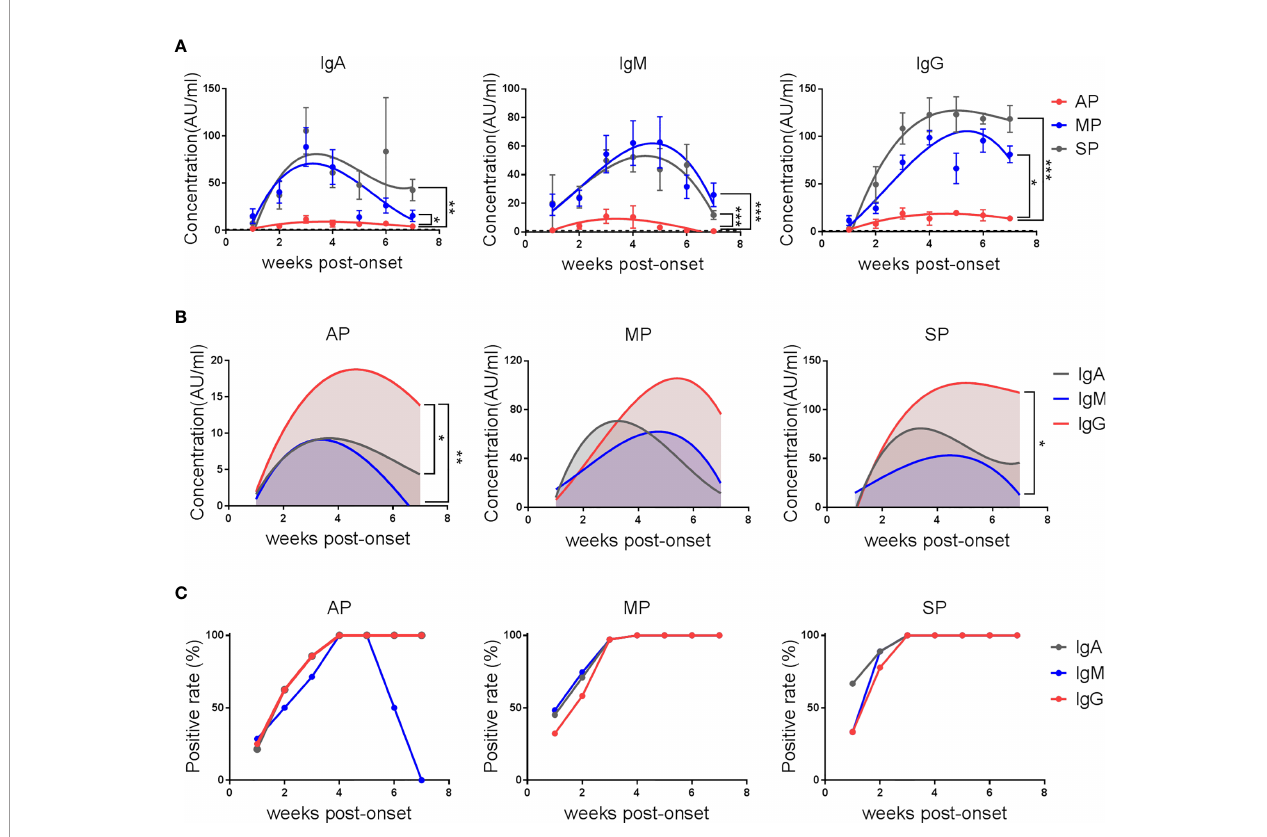
FIGURE 1 | The kinetics of anti-SARS-CoV-2-RBD IgA/IgM/IgG in COVID-19 patients. Serum IgA, IgM and IgG against the RBD protein of SARS-CoV-2 were detected by electrochemiluminescence. (A) The kinetics of anti-SARS-CoV-2-RBD IgA/IgM/IgG antibodies in AP, MP and SP groups. The line is a trend line fi tted by Nonlinear Regression method. Antibody concentrations were expressed as mean ± SEM. (B) The kinetics of different anti-SARS-CoV-2-RBD antibody isotypes in each group. The line is a trend line fi tted using the nonlinear regression method. (C) Positive rates of different anti-SARS-CoV-2-RBD isotypes over time in each group. One-way ANOVA with Holm-Sidak ’ s multiple comparisons test was used. A p-value of ≤ 0.05 was considered statistically signi fi cant (*p-values of ≤ 0.05; **p-values of ≤ 0.01; ***p-values of ≤ 0.001).